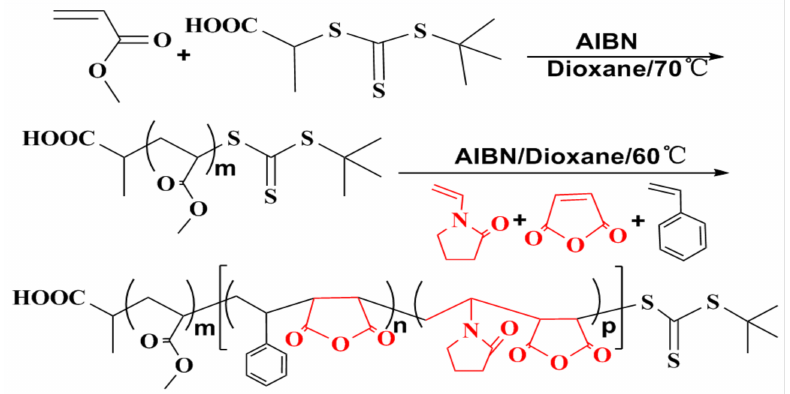
Figure 9. The synthesis process of PMA- b -P